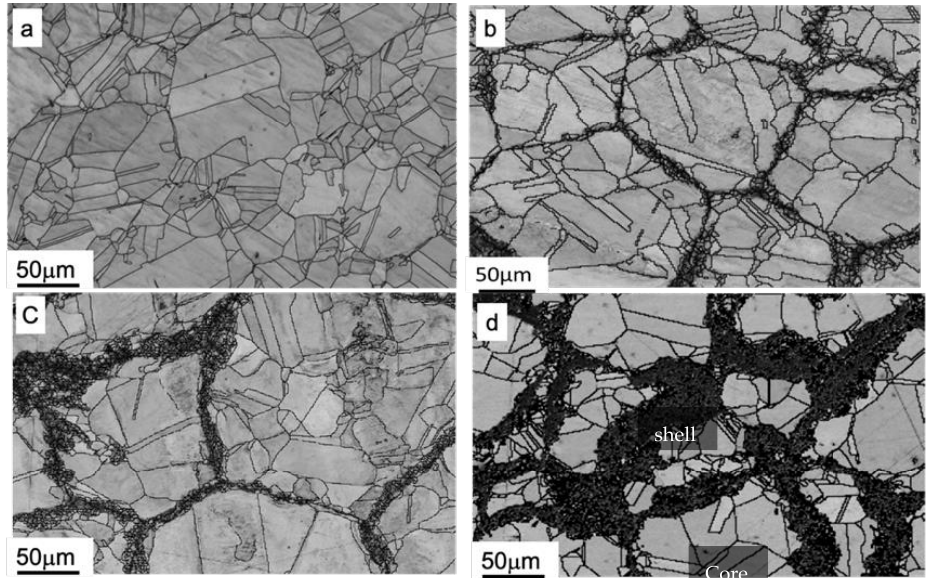
Figure 1. EBSD image quality maps overlaid with grain boundaries in cross section of compact prepared from ( a ) base material, ( b ) minimum process parameter levels (experiment #1), ( c ) medium process parameter levels (experiment #13), and ( d ) maximum process parameter levels (experiment #19). According to Table 3, the minimum process parameter levels have the largest mean core and shell grain size (30.12 µm and 4.3 µm, respectively) and result in the lowest UTS and elongation (231.03 MPa and 32.94%, respectively) when compared to the other pro- cessing conditions (excluding base material). The maximum process parameter level has the smallest core and shell mean grain size (25.87 µm and 1.8 µm, respectively) and leads to the highest UTS (282.29 MPa). However, the largest elongation (45.22%) is observed in the middle process levels. In addition, the shell volume fraction increases from 12.42% to 42.84% with increasing process parameter values. It can be clearly seen that the mechani- cal performance of the HS pure Cu is strongly dependent on the microstructural features, which are induced by the process parameter levels in the mechanical milling step. The process parameters in the mechanical milling step play an essential role in controlling the mechanical properties of HS pure Cu. Therefore, understanding these correlations was important in improving the stability of the mechanical milling process. 3.2. Influence of Process Parameters on Mechanical Performance Table 4 shows the results of the Box – Behnken design. There is a total of 30 experiment runs with two replicates. According to Table 2, each experiment number is randomly as- signed a “run” number to determine the order they would be performed in, to avoid bias in the experiment results due to the influence of some unknown factor. The experiment run numbers are also presented in Table 4, together with the values of the two response parameters. Table 4. The results of UTS and elongation according to the Box – Behnken design. Exp. No. UTS (MPa) Elongation (%)